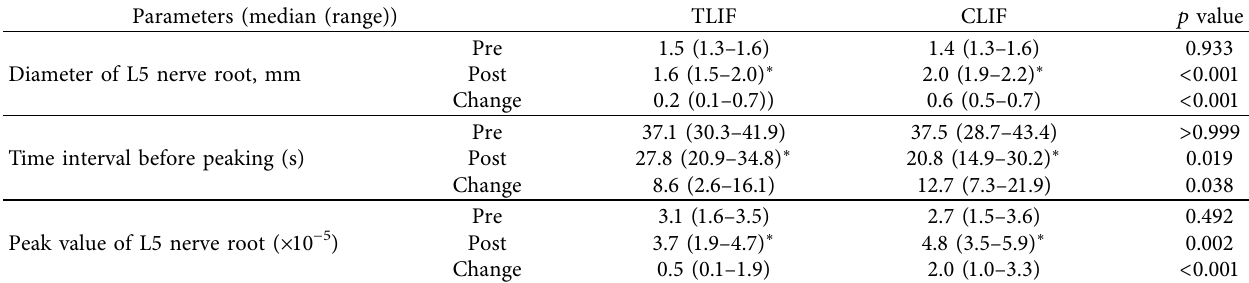
Table 4: IoUS parameters of L5 nerve root before and after surgery in the TLIF group and CLIF group. Parameters (median (range))